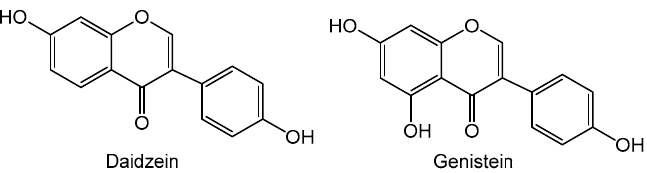
Figure 4. Examples of representative isoflavones.